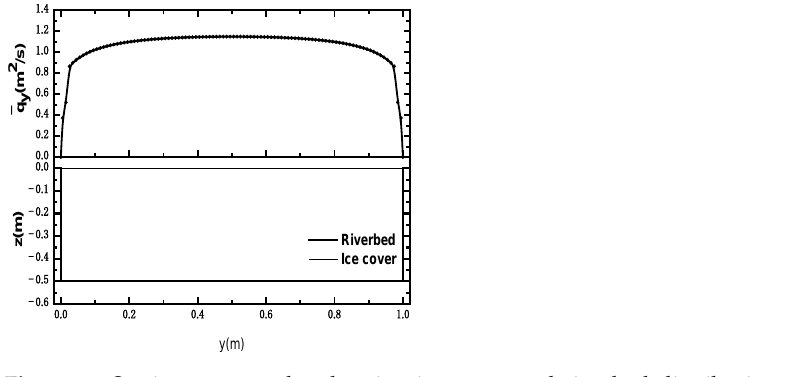
Figure 8. Section topography showing ice cover and riverbed distribution, and cross-sectional relative-unit discharge in a rectangular section.